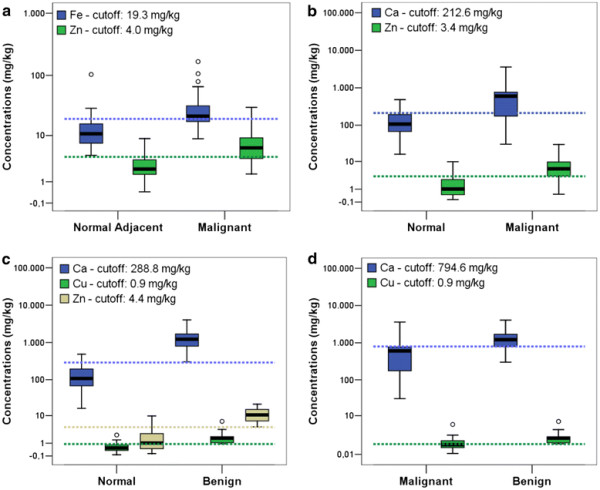
Box plots of trace elements in different breast tissues. (a) normal adjacent and malignant (b) normal and malignant (c) normal and benign and (d) malignant and benign. The circles indicate outliers, which are values between 1.5 and 3 times the inter quartile ranges. Color dotted lines represent the cut-off values for each correspondent color distribution.